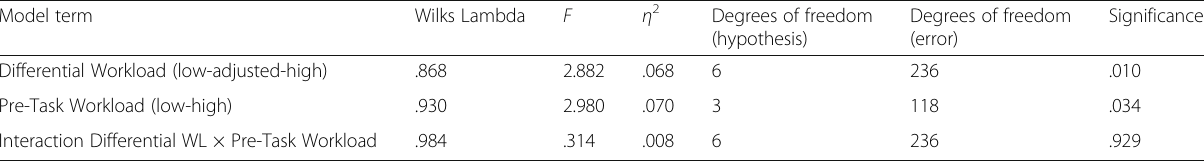
Table 4 MANOVA including DMQ scores, Differential Workload and Pre-Task Workload. Multivariate tests Model term